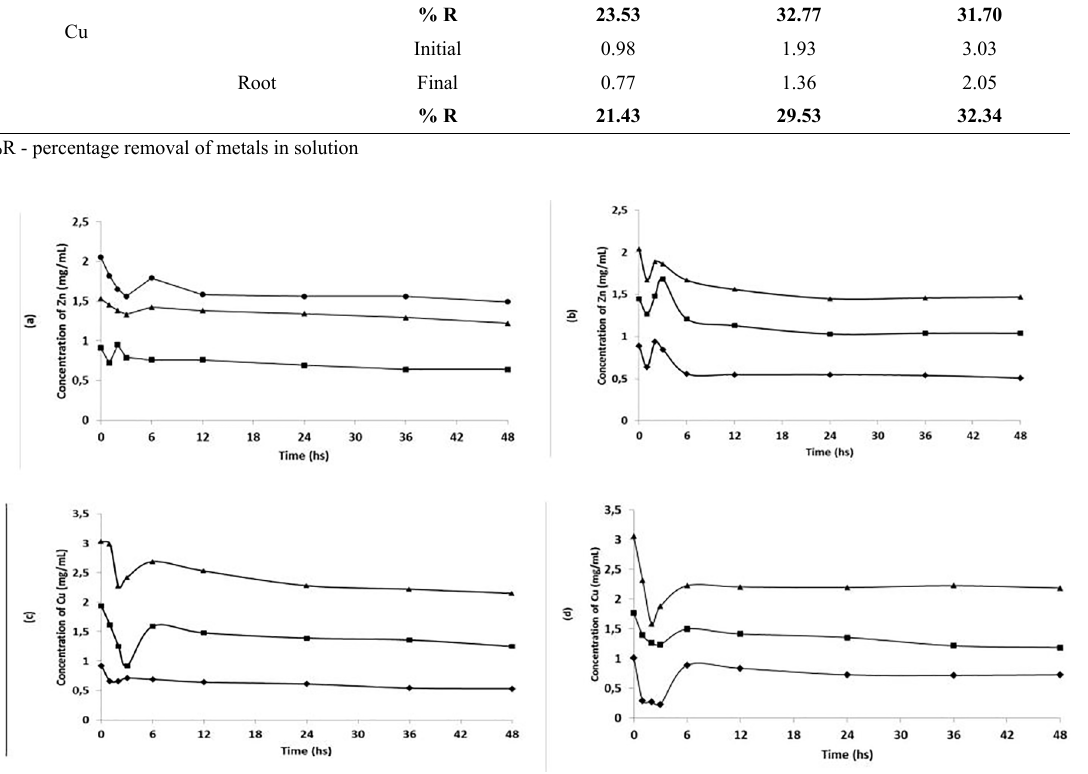
Figure 1. Concentration of Zn, (a) leaf, (b) root and Cu (c) leaf, (d) root in different treatments as a function of time counted with